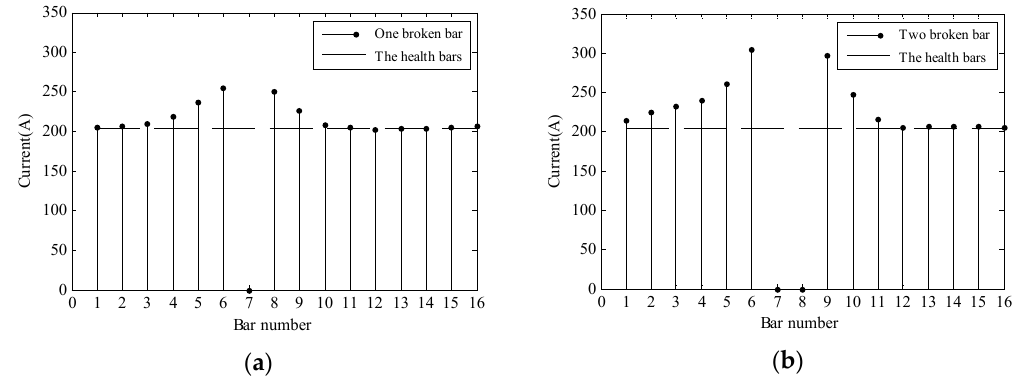
Figure 20. The current distribution: ( a ) Healthy motor cage and one-broken-bar fault; ( b ) Healthy motor cage and continuous two-broken-bars.